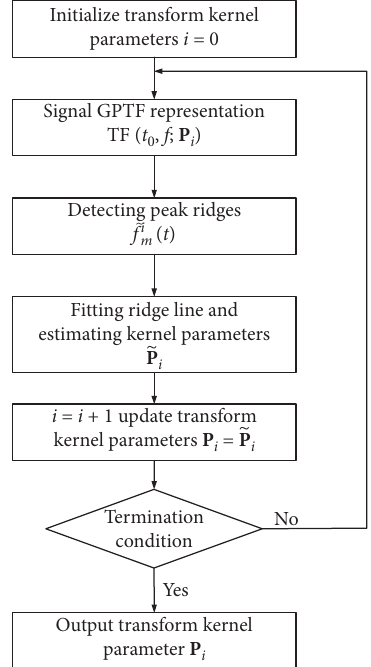
Figure 3: The flowchart of transform kernel parameter estimation.